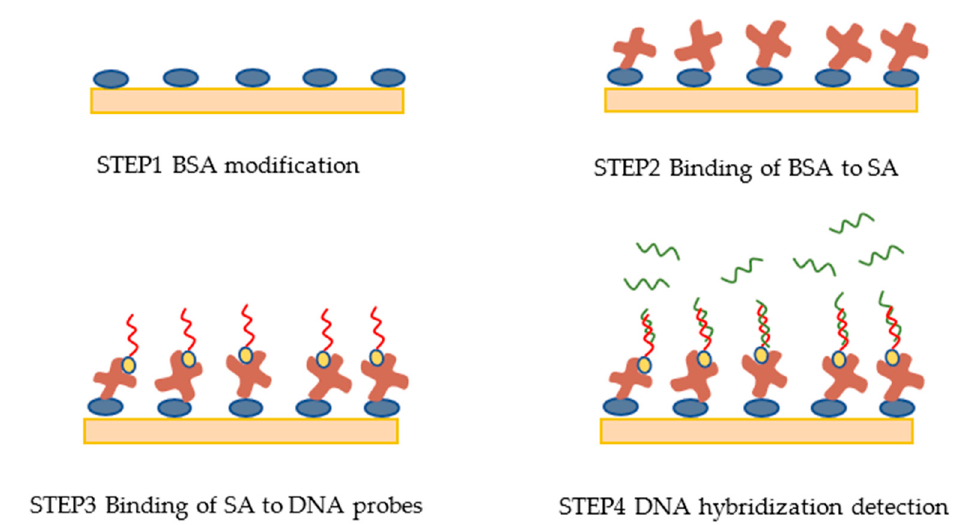
Figure 3. Schematic illustration of the experimental protocol.